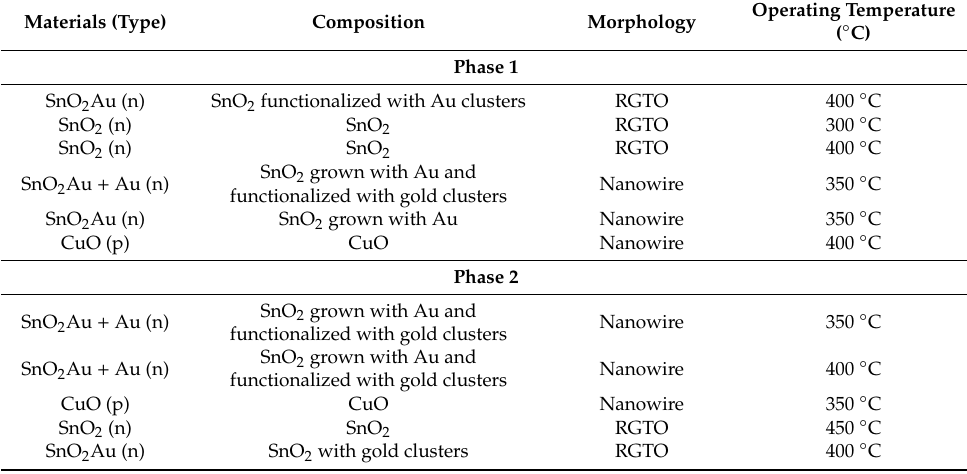
Table 3. Type, composition, morphology and operating temperature for S3 sensors made at the SENSOR Laboratory. Sensors are divided for the two di ff erent phases of